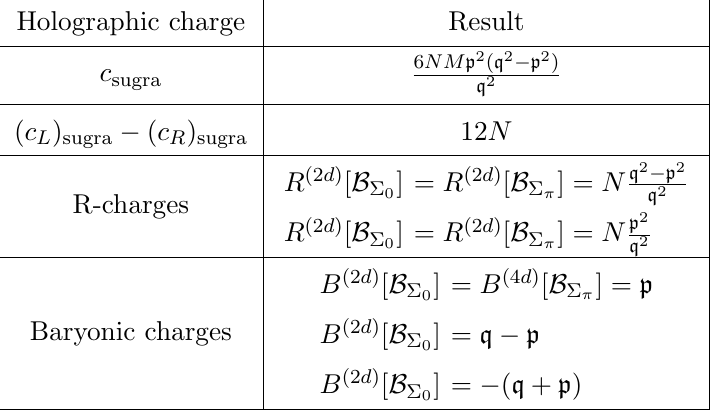
Table 4 . Holographic charges of the Baryonic twist for Y p ; q